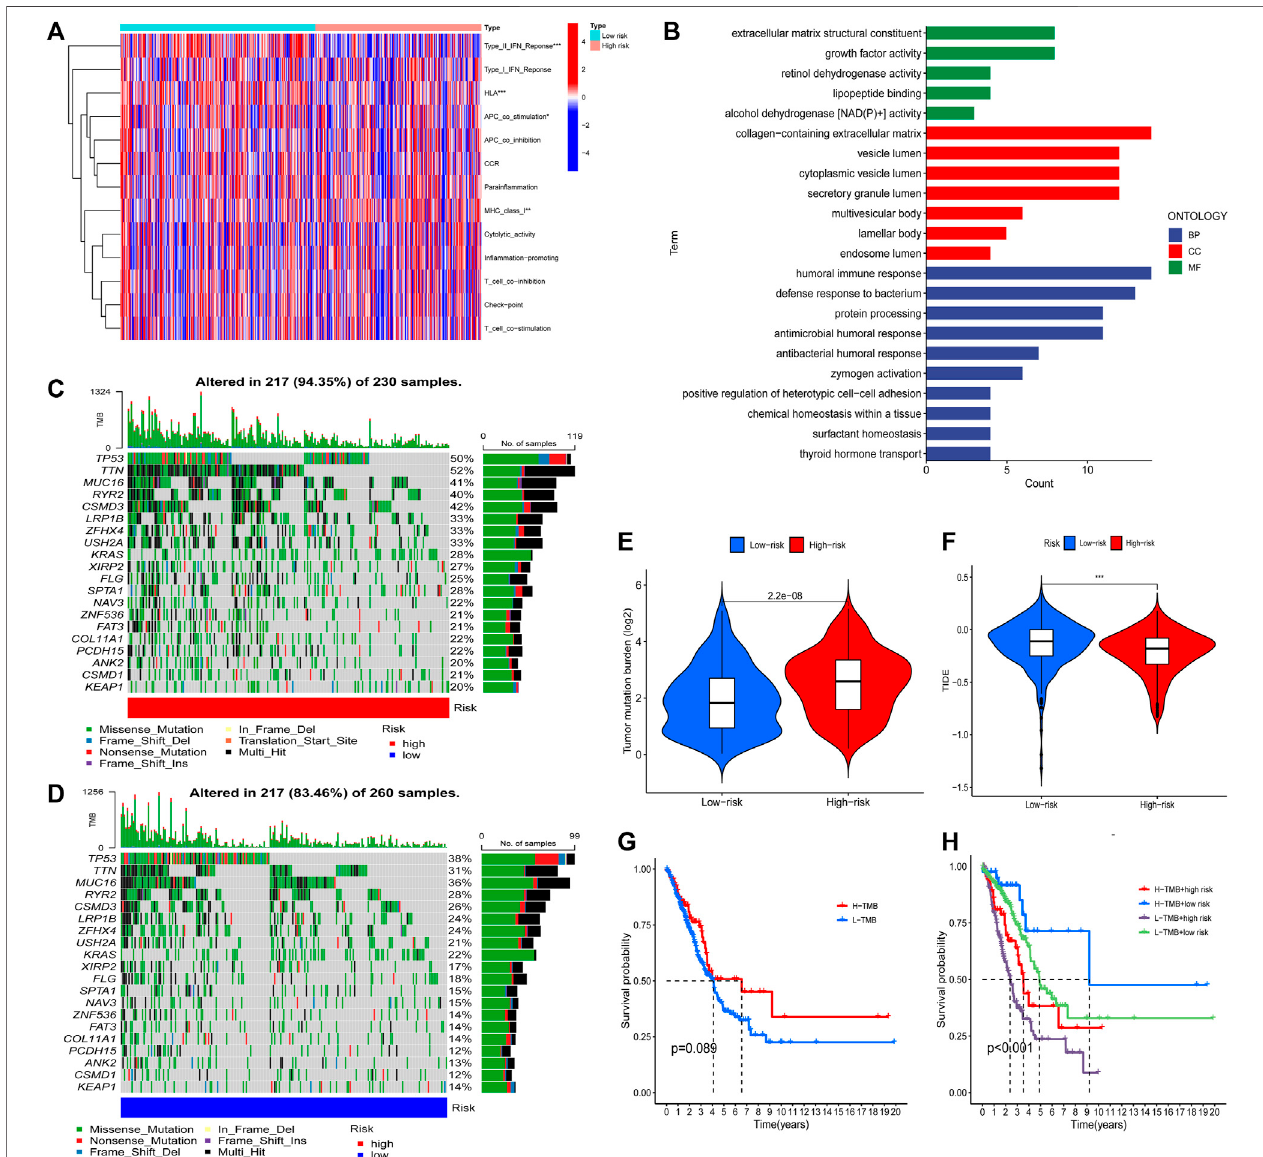
FIGURE 5 | The tumor immune microenvironment and cancer immunotherapy response were assessed using a model of FAM-associated lncRNAs across the TCGAgenome. (A) Indicatorcriteriaforeachpatient ’ simmuneindex. (B) GOenrichmentanalysis. (C and D) Waterfallplotsshowingmutationinformationforgeneswith high mutation frequency in high- (C) and low-risk groups (D) . (E) Differences in tumor mutational burden between high- and low-risk patients. (F) Differences in TIDE betweenhigh-and low-riskpatients. (G) K – Mcurve analysisofpatient OSaccordingtoTMB. (H) K – McurveanalysisofpatientOSaccording tomodelriskofTMB and FAM-related lncRNAs. ***, p <